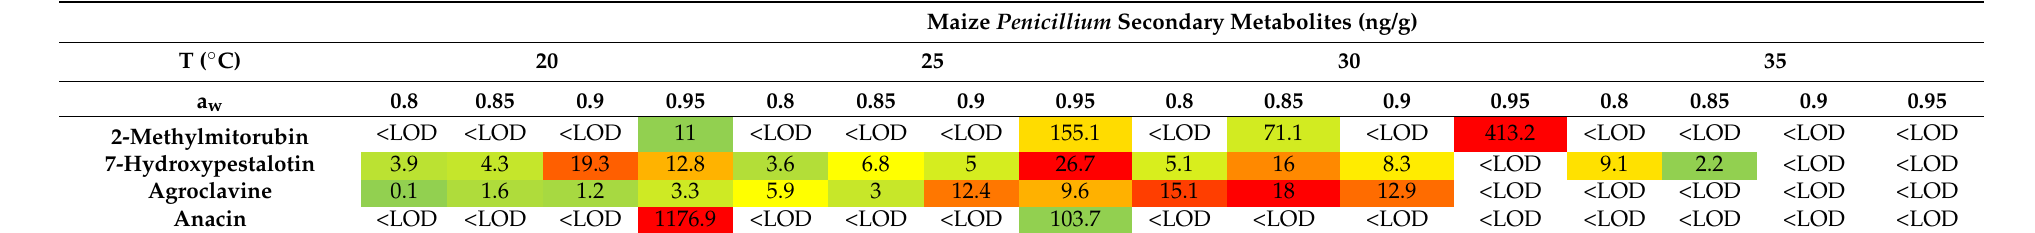
Table 3. Detailed list and mean amounts of secondary metabolites ( µ g/g) found in maize related to colonization by Penicillium species. The conditions highlighted in green (low concentrations), yellow (medium concentrations) and red (highest concentrations) were found; LOD: Limit of